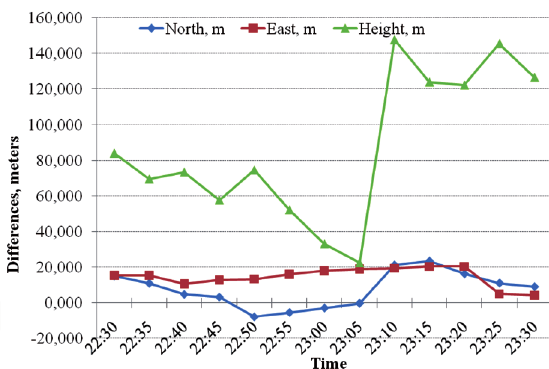
Fig. 5. Values of CPOS station called NYA1 in